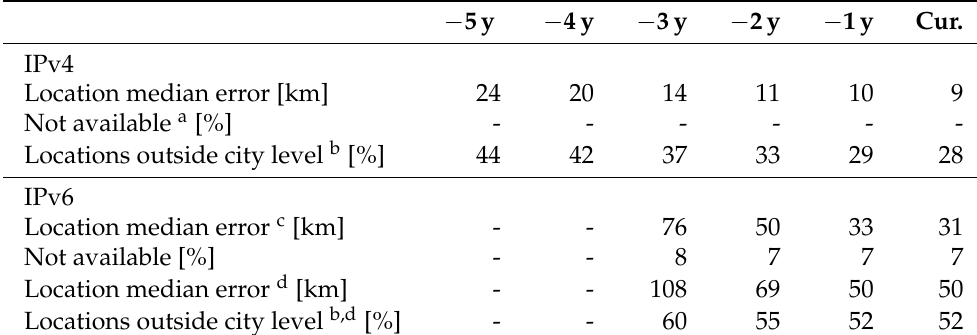
Table 2. Late location of IPv4 and IPv6 addresses.